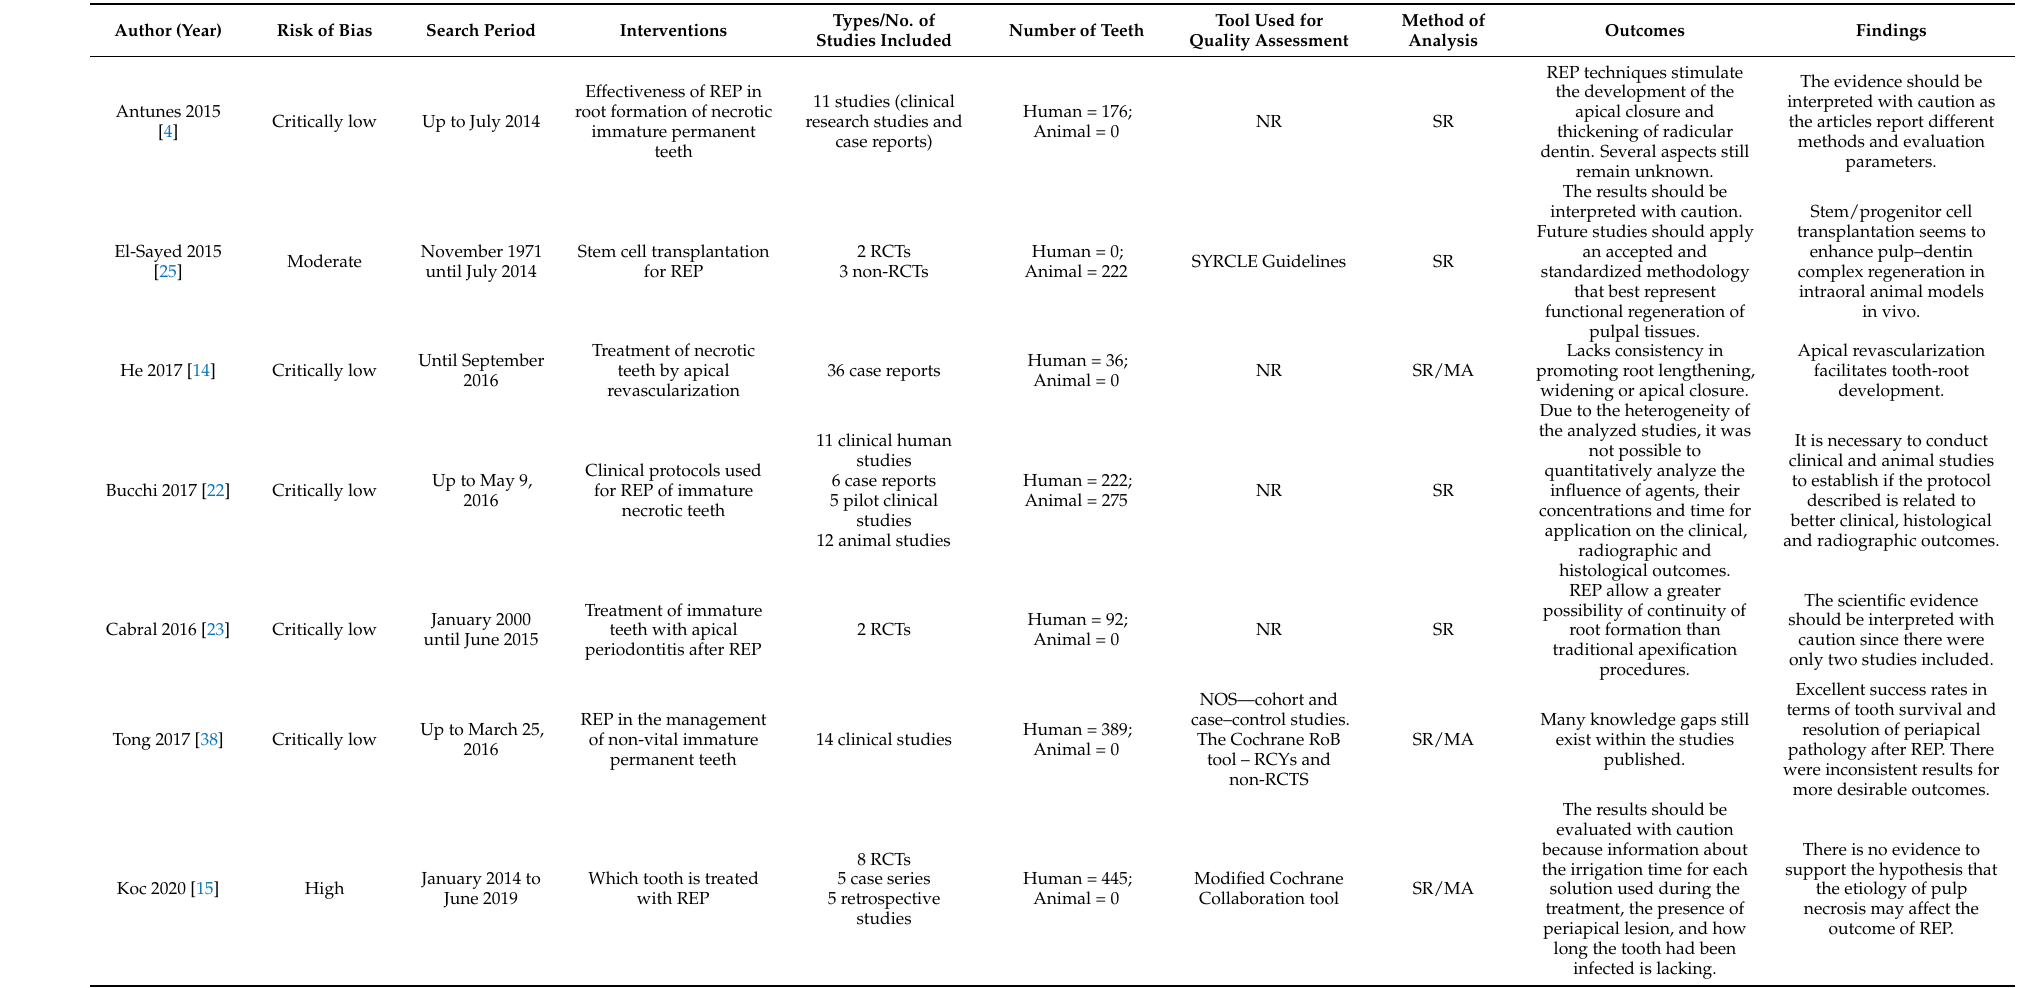
Table 1. Baseline